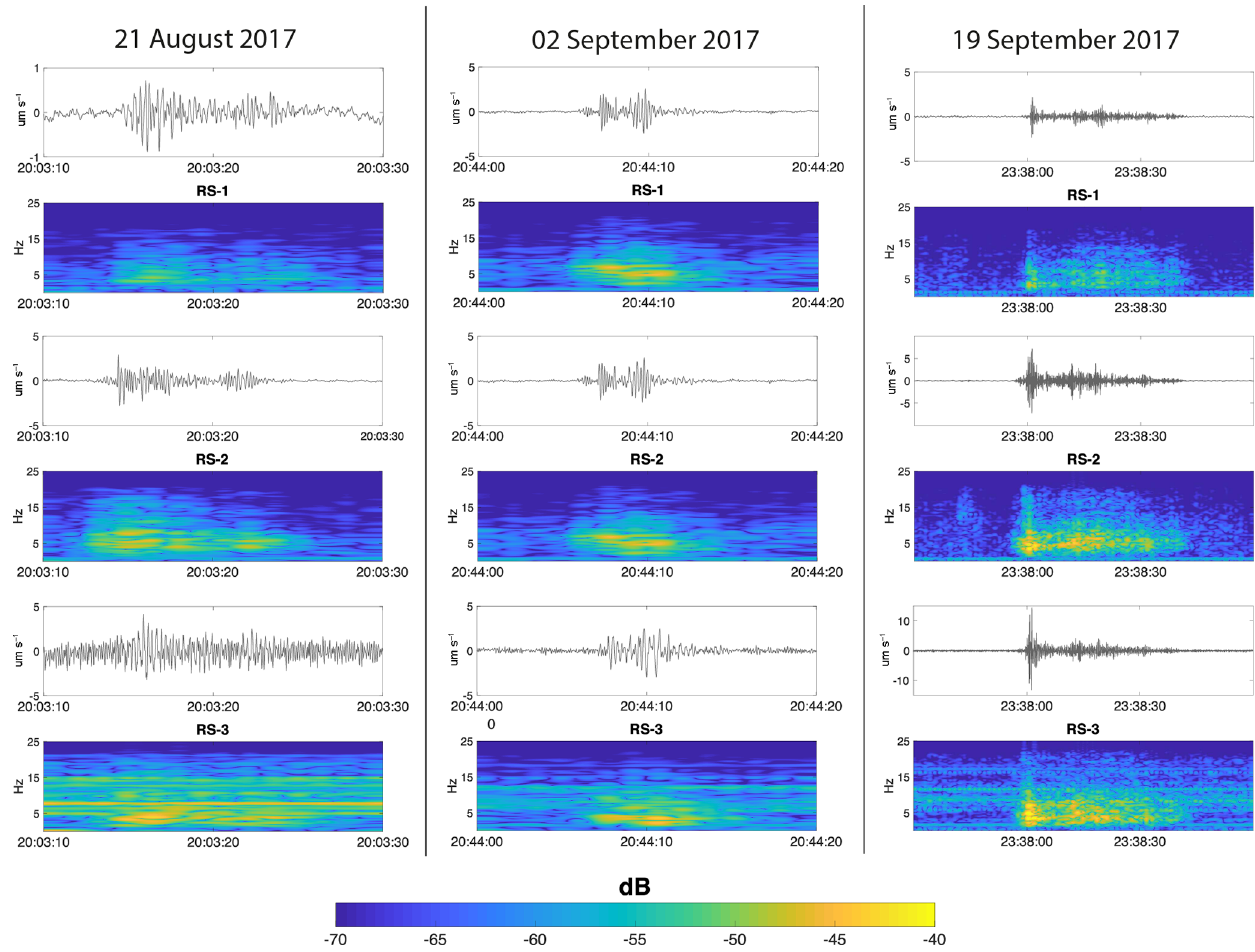
Figure 4. Selection of signals associated with rockfall events. Signals are band-pass filtered (Butterworth, second-order) between 0.5 and 15Hz Times are in UTC. Note the high noise level at station RS-3 caused by the cable-car operations (see also Sect. 4 for more